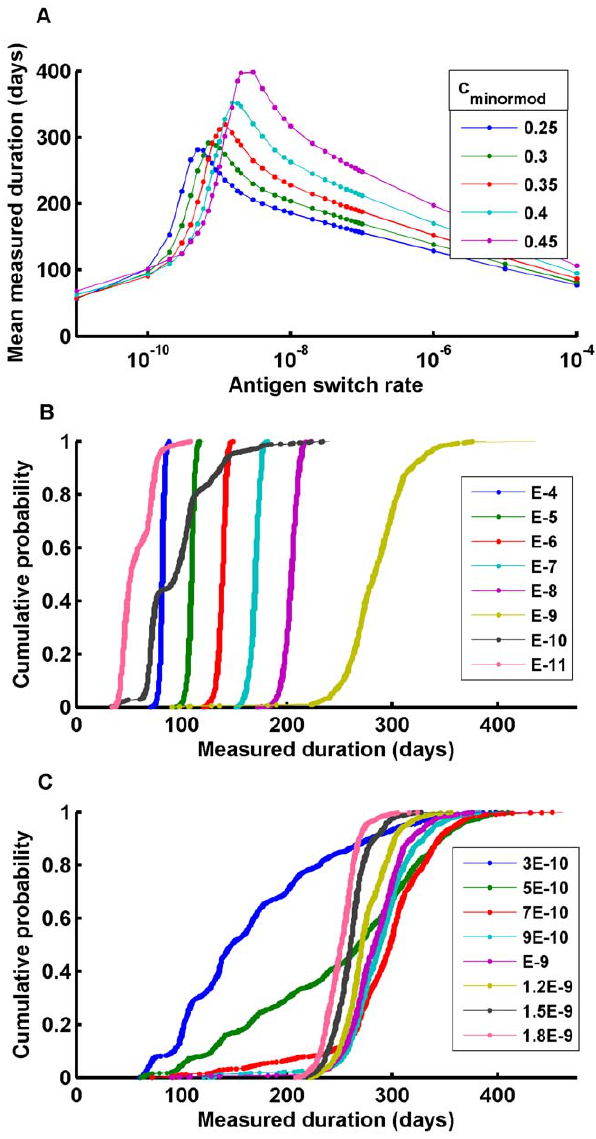
Figure 3. Measured infection durations governed by host immune reponse and parasite antigenic switching. A) Effect of antigenic switch rate on mean infection duration for five values of non- specific antigenicity c minormod (X 50,innate= 1000, X 50,antibody =10 with min stimulation 1/100, C antibody =1.5, nonspec_growth=0.5, C innate =0.2, merozoite growth 0.05, merozoite antibody invasion blocking 0.5); B) Duration distributions for a range of antigenic switch rates K antigen with c minormod =0.3; C) Duration distributions for antigenic switch rates near maximum duration have the characteristic distribution shape for P. falciparum .